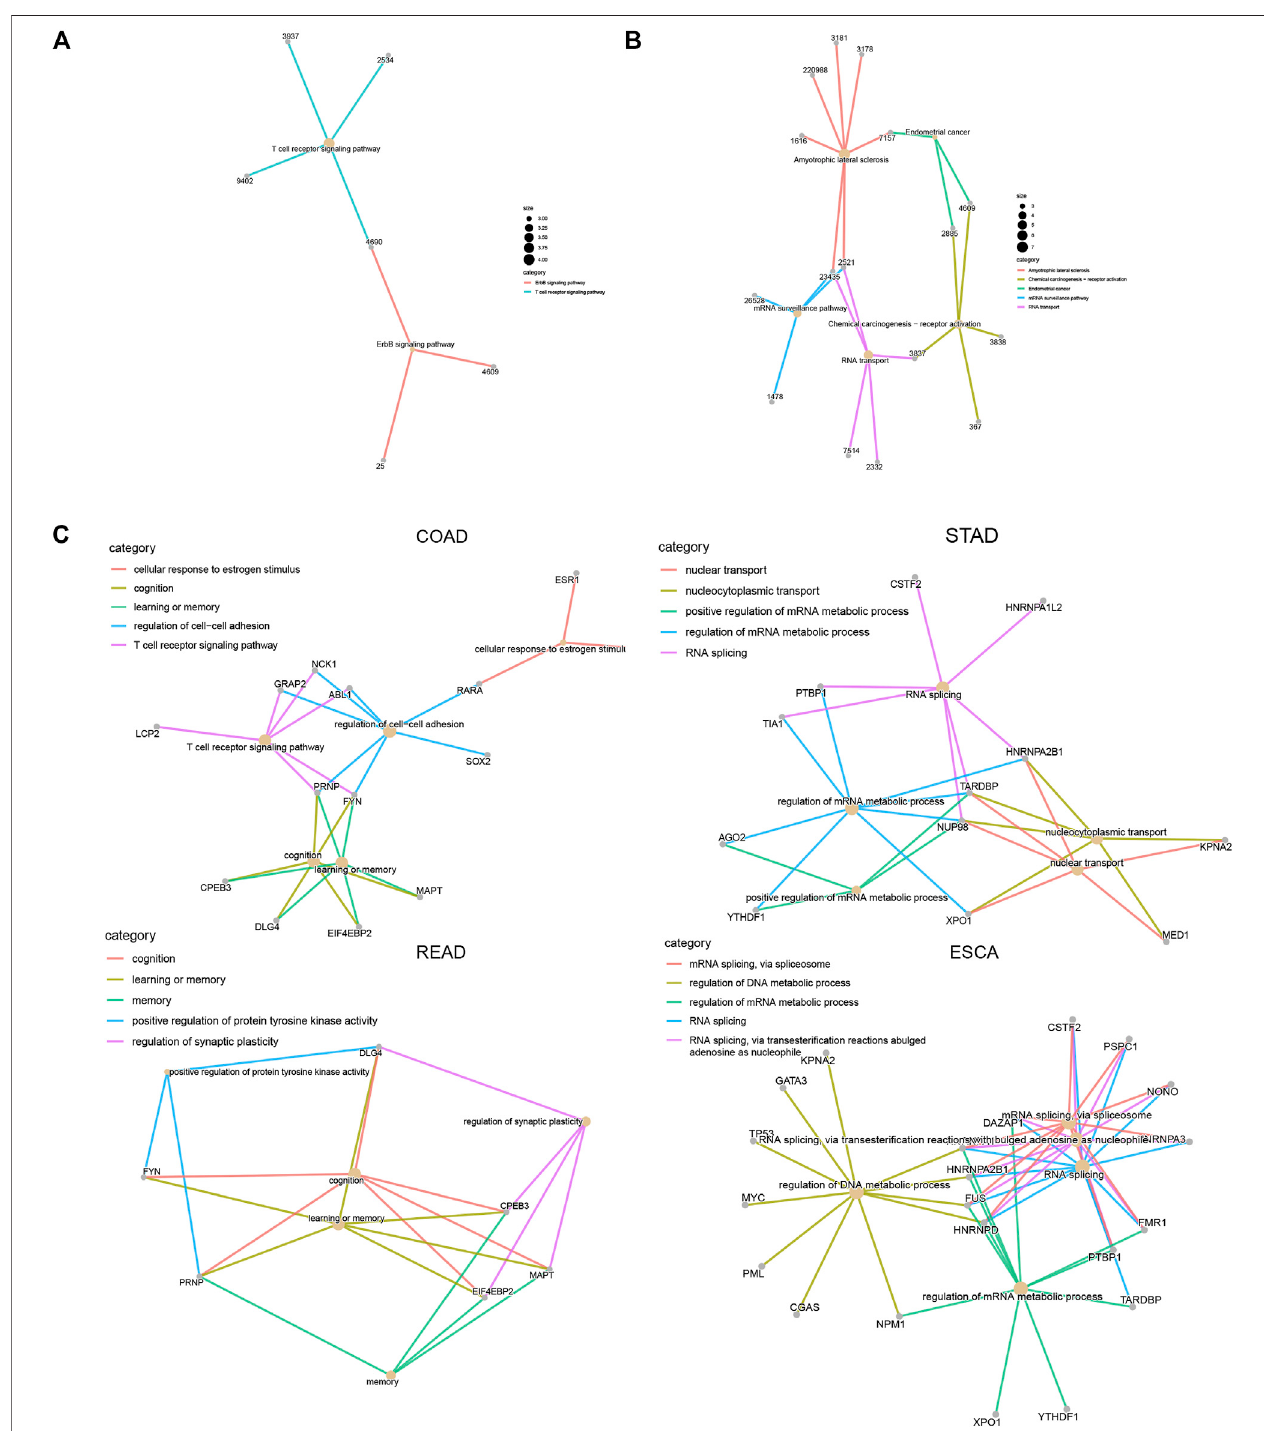
FIGURE 10 | Construction of LLPS regulators – signaling network in digestivesystem neoplasms. (A – B) Construction ofLLPS regulators – KEGG signaling network in COAD (A) and ESCA (B) . (C) Construction of LLPS regulators – biological processes in COAD, STAD, READ, and ESCA.